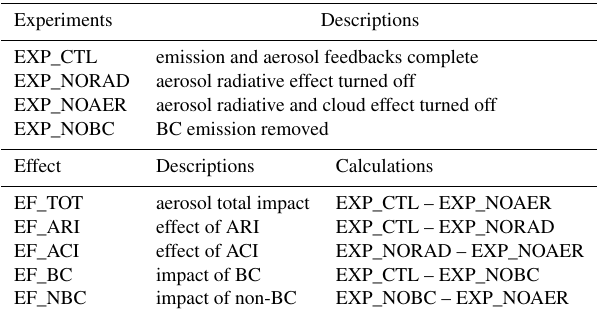
Table 2. Experiments and the effects of different aerosol feedback